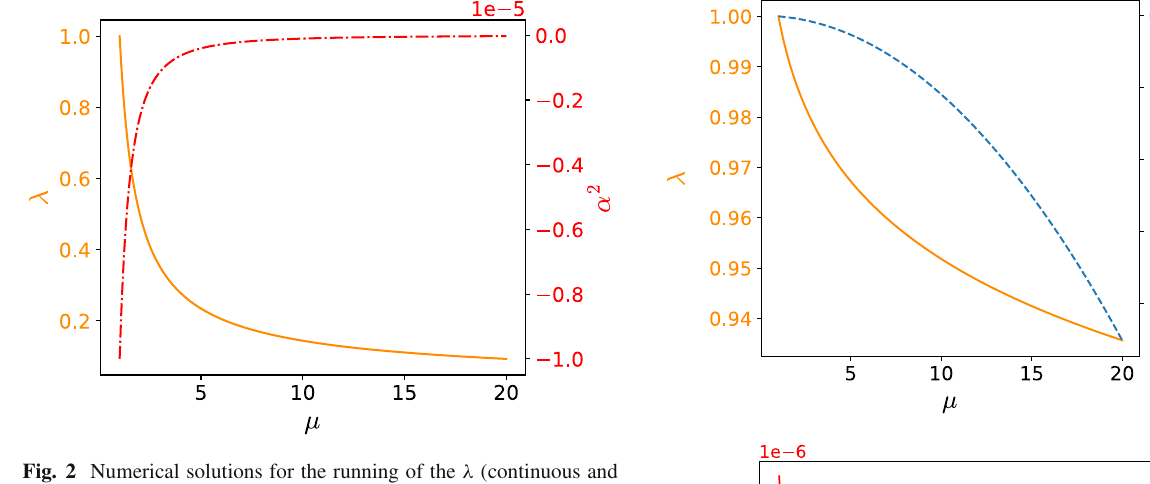
(cid:11) (cid:10) 1 , 10 , − 10 − 5 , − 10 − 1 , 10 − 4